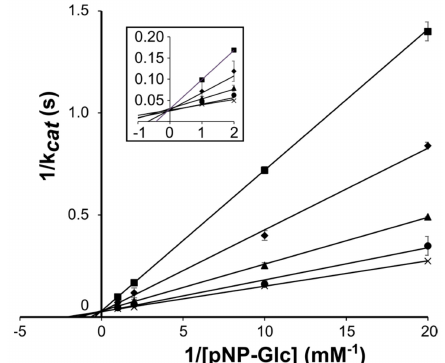
Figure 3. Lineweaver plot of wild-type Dt Gly inhibition with increasing concentrations of Glc S Biz. Data are expressed as mean ± SD from three independent experiments. Inhibitor concentrations are respectively depicted as crosses (0 µ M), circles (100 µ M), triangles (250 µ M), diamonds (500 µ M) and squares (1000 µ M). Inset: 2X zoom on axes origin highlighting the intersection of fitted lines on y